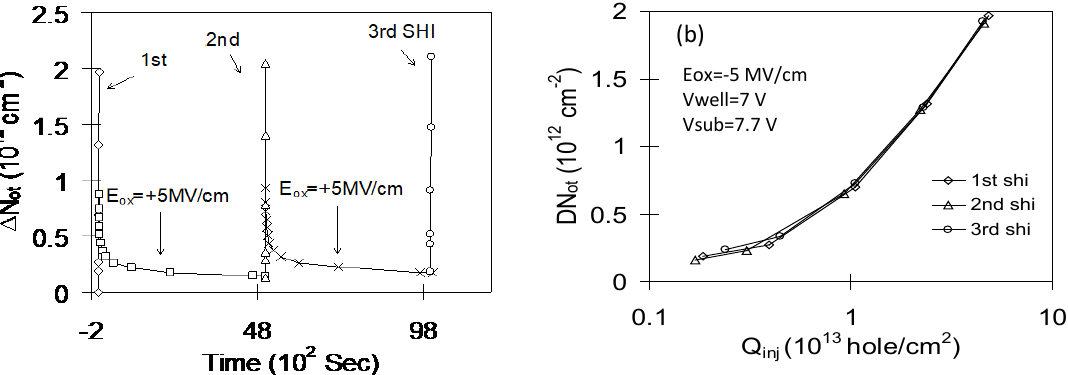
Figure 9. ( a ) As-grown traps can be repeatedly filled and then discharged; ( b ) the first filling and subsequent re-filling agreed well [48].